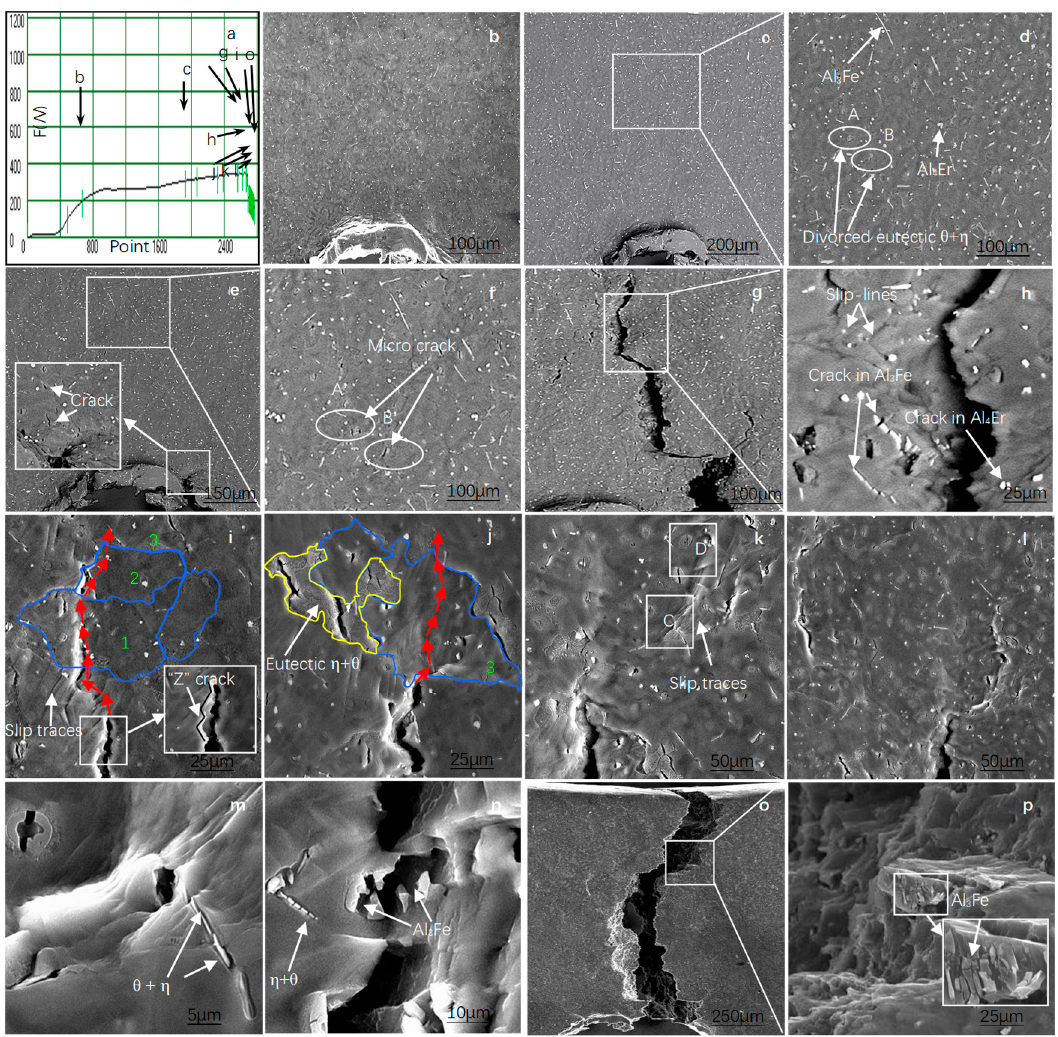
Figure 6. In situ tension test of the alloy at room temperature.( a ) Load-position curve; ( b ) SEM image of Position b shown in ( a ); ( c ) SEM of Position c shown in ( a ); ( d ) Enlarged image of the selected area shown in ( c ); ( e ) SEM image at F = 340 N; ( f ) Enlarged image of the selected area shown in ( e ); ( g , h,i,j,k,l ) SEM images of Positions g, h, i, j, k, and l shown in ( a ); ( m ) Enlarged image of the selected area C shown in ( k ); ( n ) Enlarged image of the selected area D in ( k ); ( o ) SEM image of the fractured specimen; ( p ) Enlarged image of the selected area in ( o ).